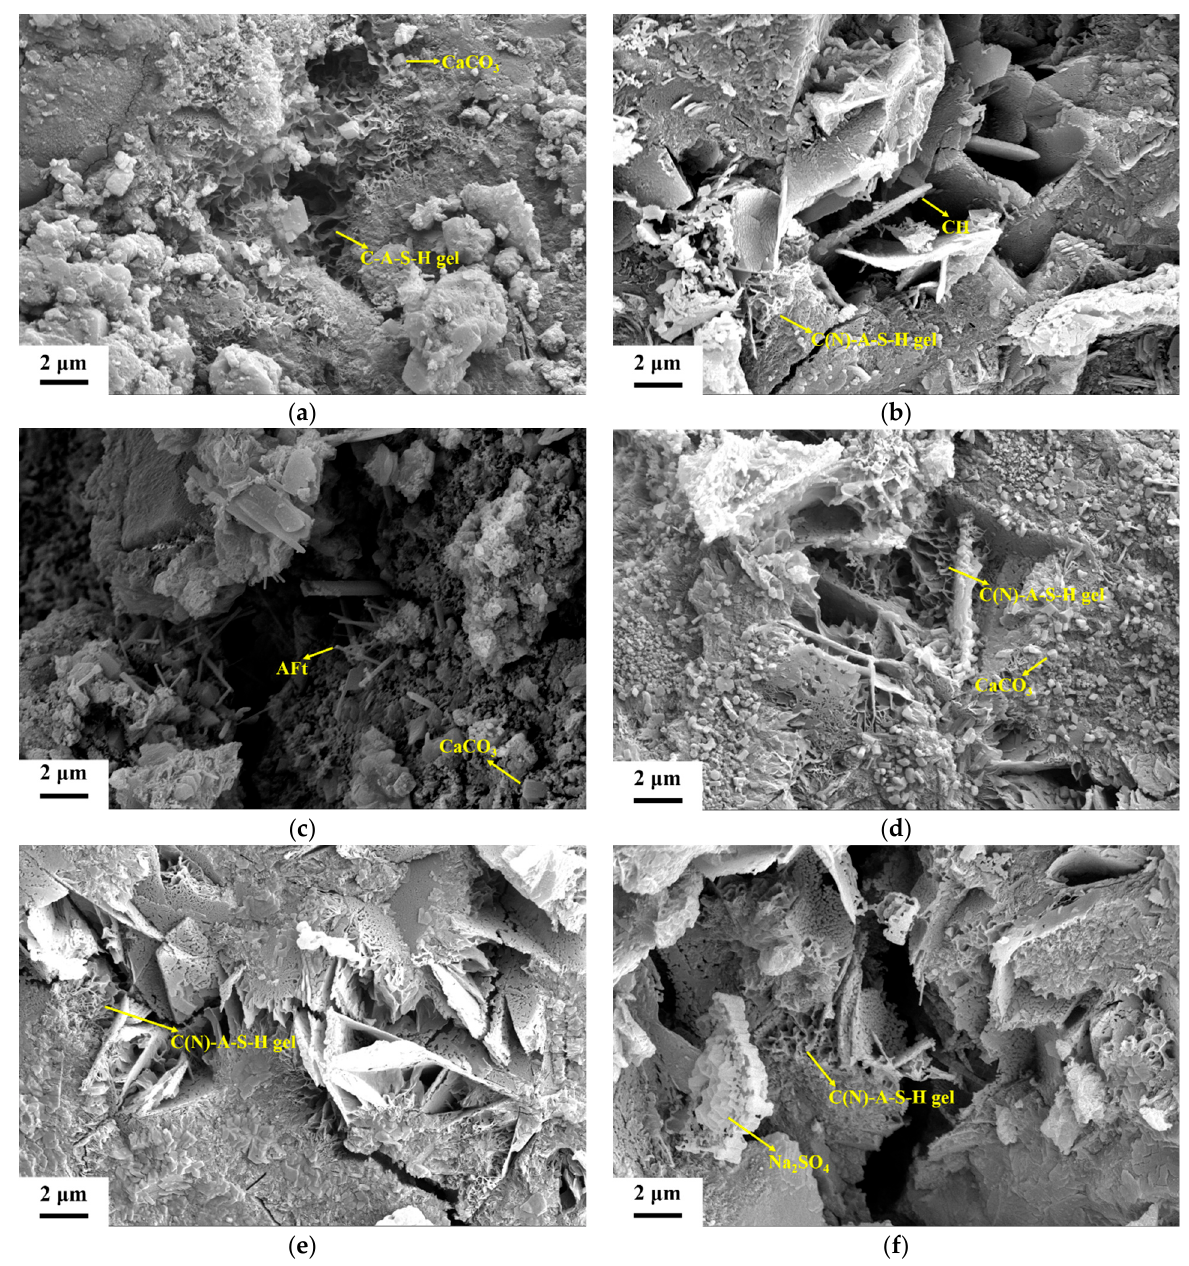
Figure 14. SEM test of the cement paste at 28 days: ( a ) S; ( b ) FG-5; ( c ) FG-25; ( d ) FGDG-3; ( e ) FGDG-6; ( f ) FGDG-12. As shown in Figure 14, with the increase in the curing period, the morphology of the paste tended to coexist with AFt and gels. At the same time, a part of the Ca(OH) 2 crystals was carbonized to form CaCO 3 . When the content of gypsum was high, it was difficult to observe obvious hydration products in the pastes, and more of them were covered by the Na 2 SO 4 crystal